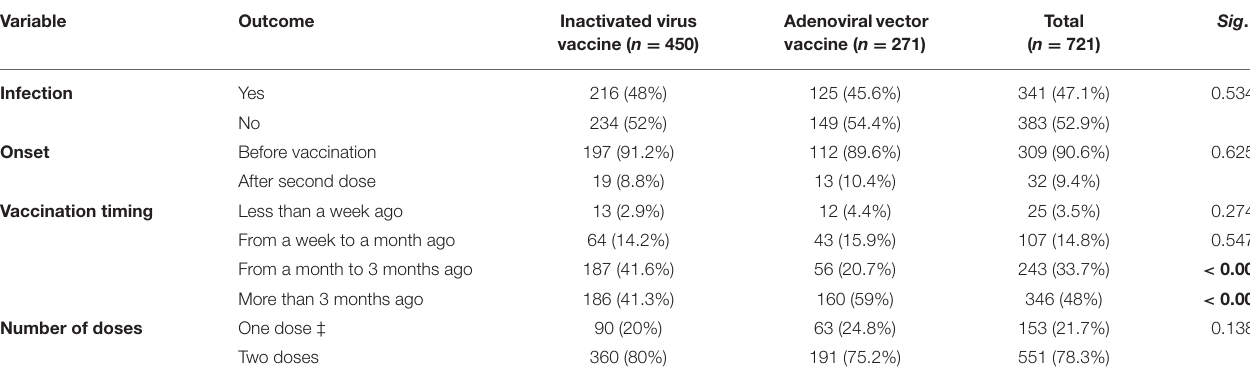
TABLE 2 | COVID-19-related anamnesis of Algerian healthcare workers receiving COVID-19 vaccines ( n = 721).